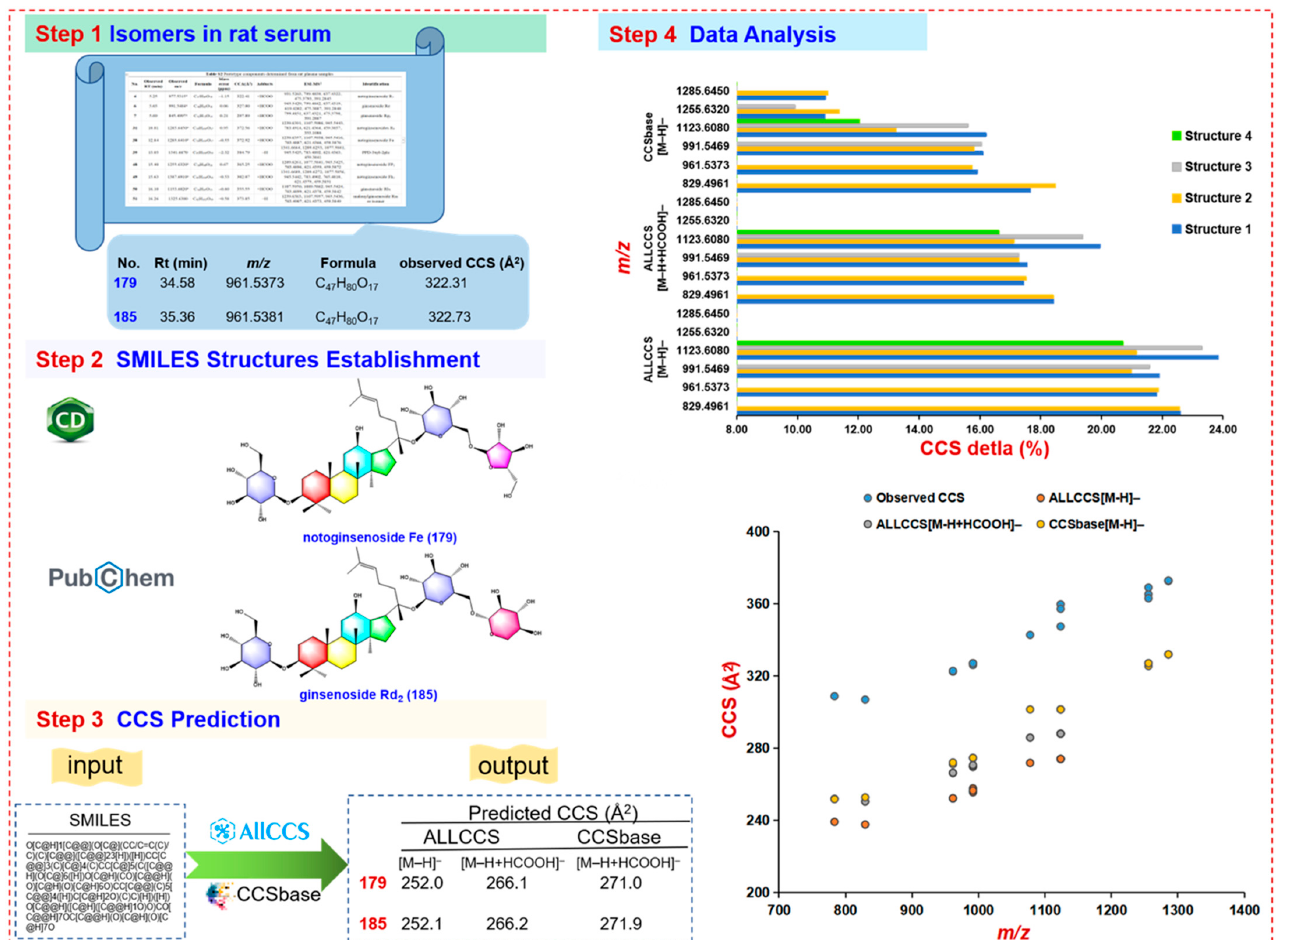
Figure 7. CCS prediction of ginsenoside isomers in rat plasma by ALLCCS and CCSbase. Step 1 to step 3: the isomer prediction and matching strategy based on ALLCCS and CCSbase; step 4: the selected m/z values and their CCS prediction and matching errors. Those selected ginsenoside isomers are annotated: m/z 829.4961 ( 202# -F2; M5 -Rg2), m/z 961.5373 ( 179# -noto-Fe; 185# -Rd2), m/z 991.5469 ( 6# -Re; M8 -gypenoside XVII; M7 -Rd), m/z 1123.6080 ( 84# -Rb2; 90# -Rb3; 97# -noto-L; M4 -vina-R7), m/z 1255.6320 ( 48# -noto-FP2; 61# -noto-Fc; 66# -Ra1), m/z 1285.6450 ( 31# -noto-R4; 38# - noto-Fa).